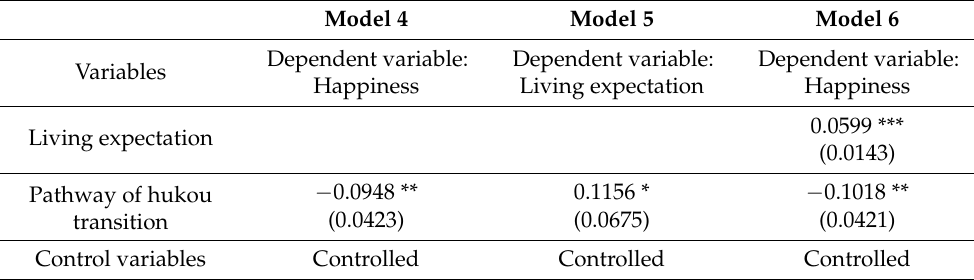
Table 6. Estimation of living expectation